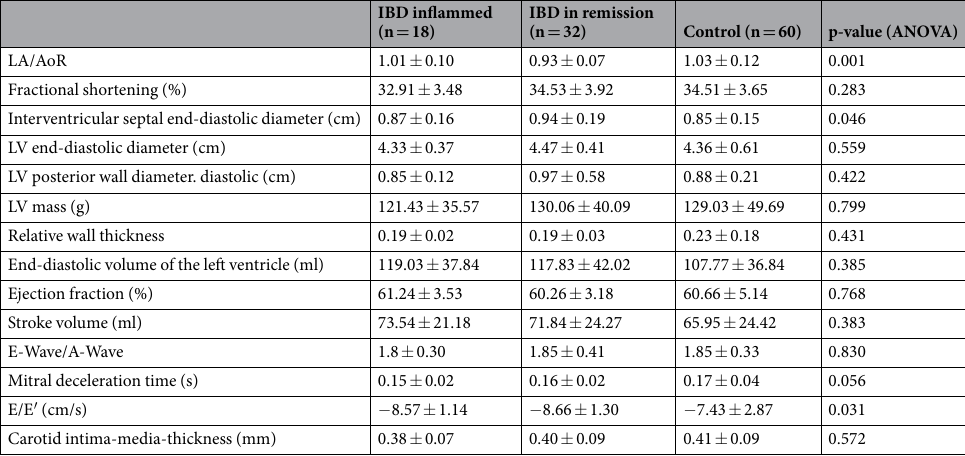
Table 2. Conventional echocardiographic parameters derived from two-dimensional and Doppler